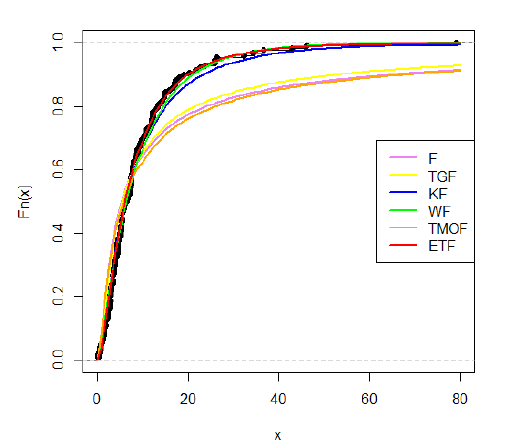
Figure 4 – Fitted cdf plots and the empirical distribution of the data